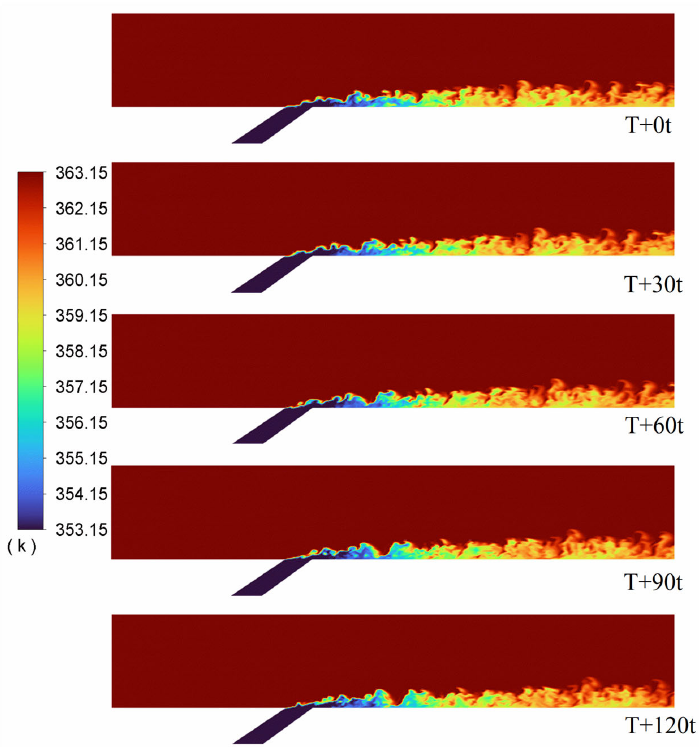
Figure 14. Instantaneous temperature distribution at different times on the central section of Case 4.